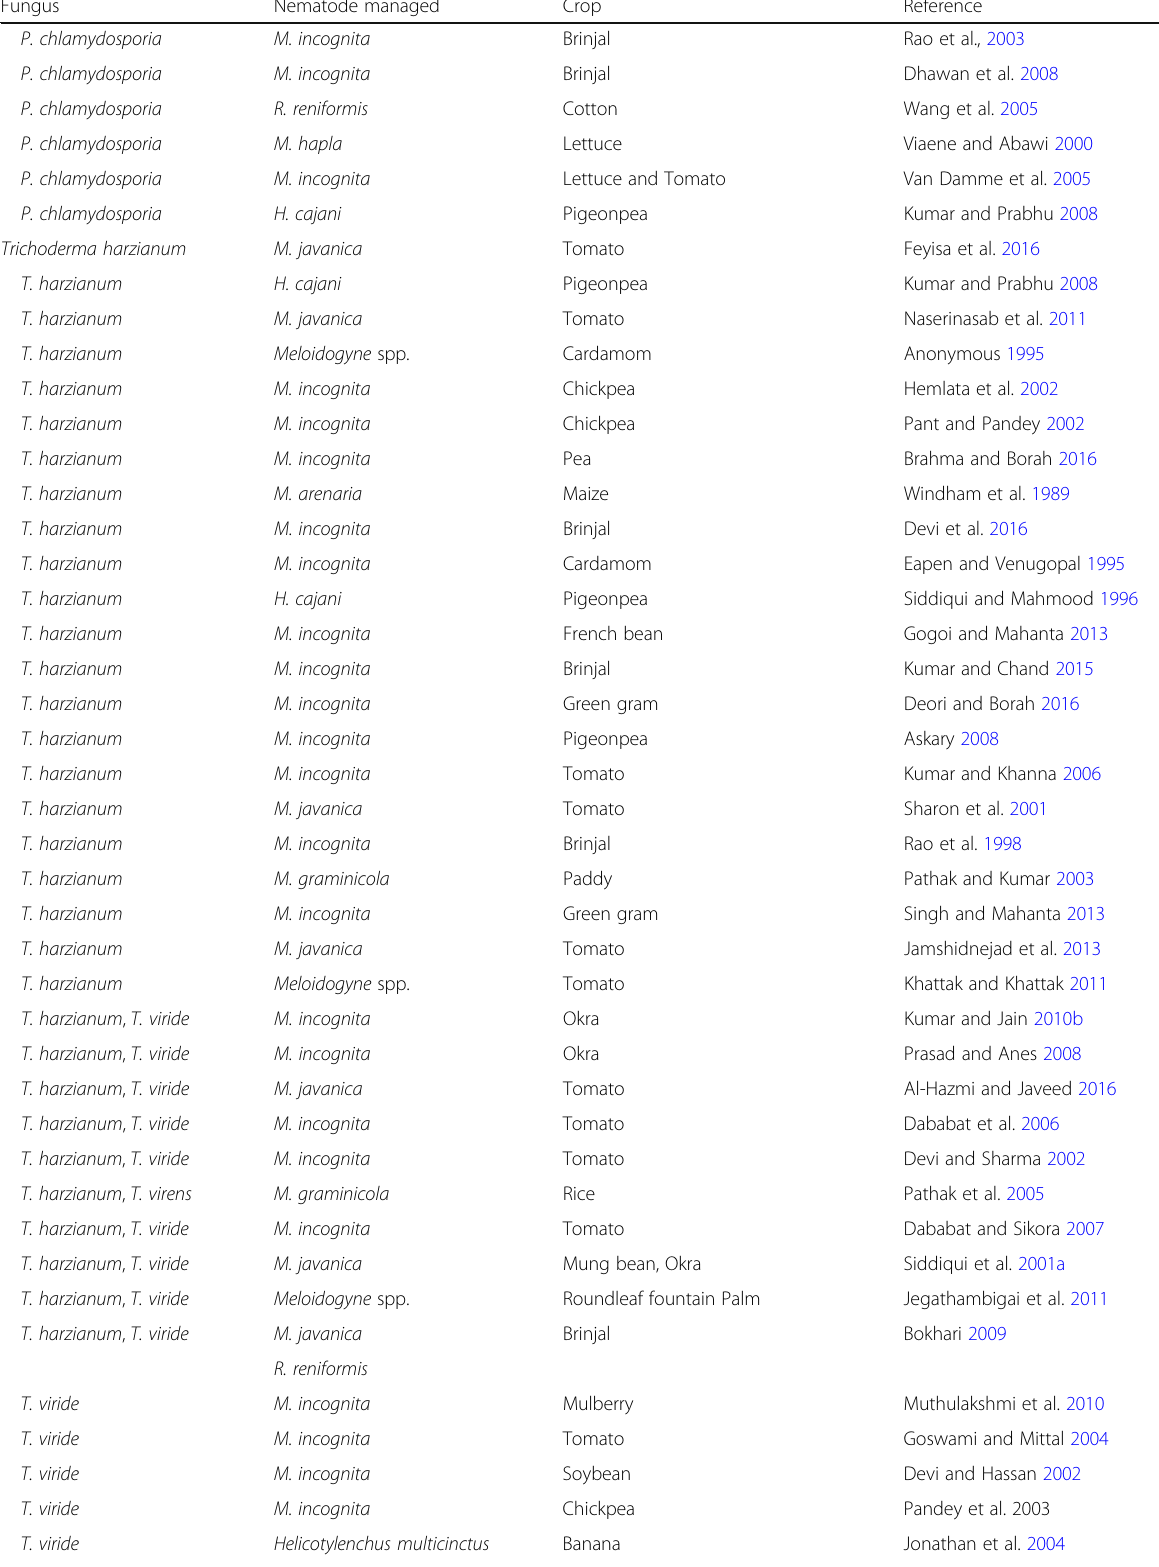
Table 4 Biocontrol agents of fungal species targeting nematodes on economic crops (Continued)